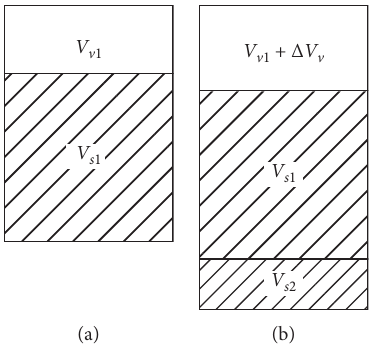
Figure 1: Phase diagram: (a) single-grain sand; (b) binary